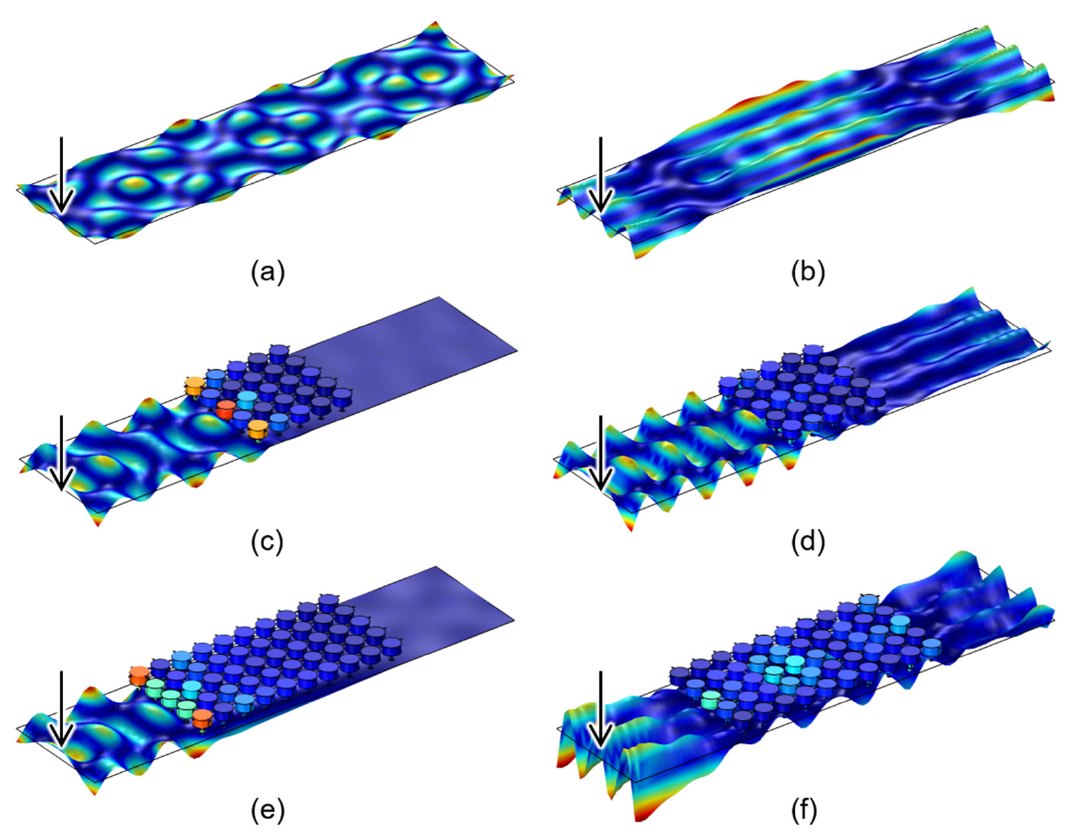
Figure 7. Displacement field of a multi-celled interconnected metamaterial along the z-direction at 2000 Hz (out of stopband) and 1188 Hz (center frequency of stopband); frequency response of ( a ) bare plate, plates with ( c ) 5 × 5 and ( e ) 5 × 10 metamaterials at 1188 Hz; frequency response of ( b ) bare plate, plates with ( d ) 5 × 10 and ( f ) 10 × 10 metamaterials at 2000 Hz .